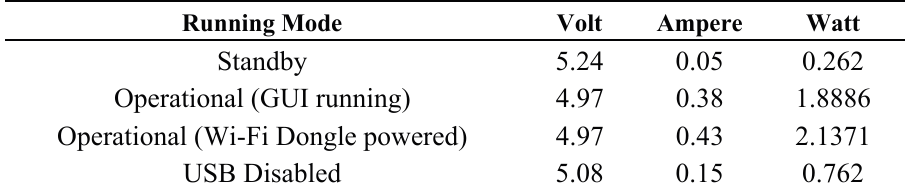
Table 3. Energy consumption model of RaspberryPI, model “B”.